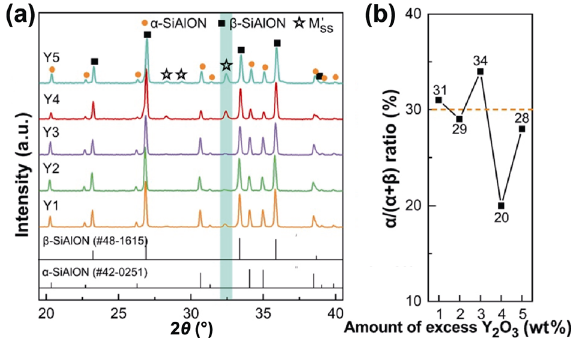
Fig. 7 (a) XRD patterns (M' SS : aluminum-containing melilite phase, Y 2 Si 3– x Al x O 3+ x N 4– x ), and (b) α /( α + β ) ratio of the α / β -SiAlON ceramics with different amounts of excess Y 2 O 3 ( m = 1.7, n = 1.0, z = 0.7, synthesized at 1750 ℃